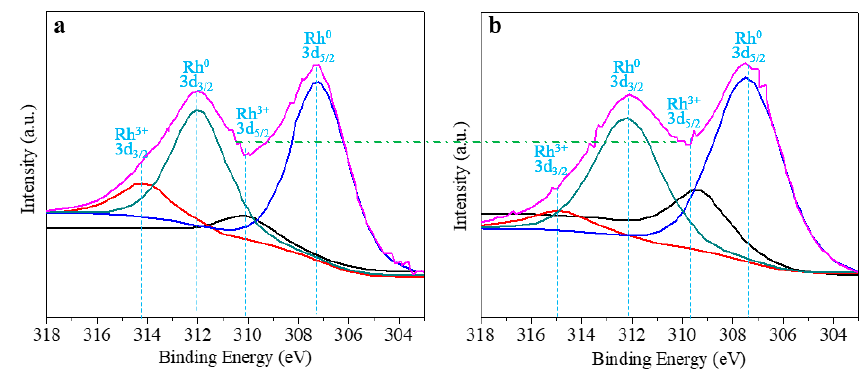
Figure 4. ( a ) XPS of Rh/ γ -Al 2 O 3 catalyst from ALD; ( b ) XPS of Rh/ γ -Al 2 O 3 catalyst from IWI.